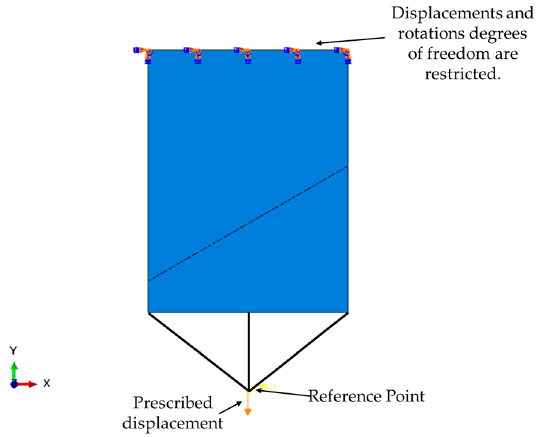
Figure 3 . Finite element model and boundary conditions . Figure 3. Finite element model and boundary